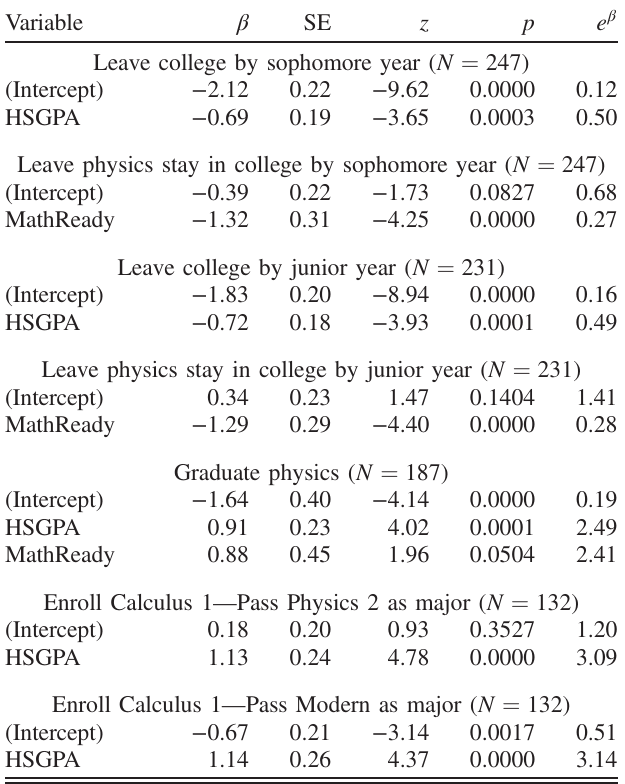
TABLE IV. Institution 1: Logistic regression. All regressions are significant improvements over the null model ( p < 0 . 001 ). β is the normalized regression coefficient, SE is its standard error, z is the z score of the coefficient, p the probability a value larger than z occurred by chance, and e β is the odds